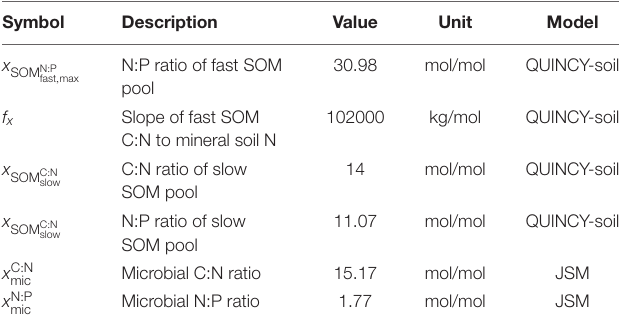
TABLE 3 | Parameter for sensitivity